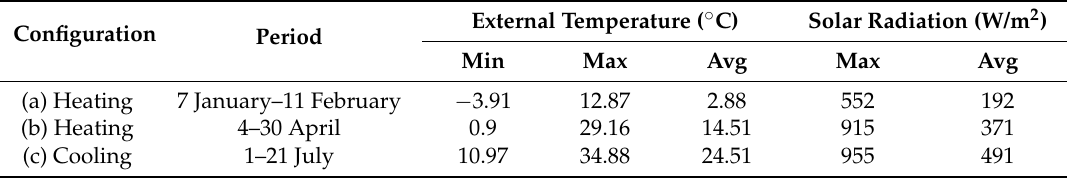
Table 2. Heating and cooling periods and weather data. The period of diurnal average of solar radiation is: (a) from 11 a.m. to 4 p.m.; (b) from 8 a.m. to 6 p.m.; (c) from 8 a.m. to 9 p.m.